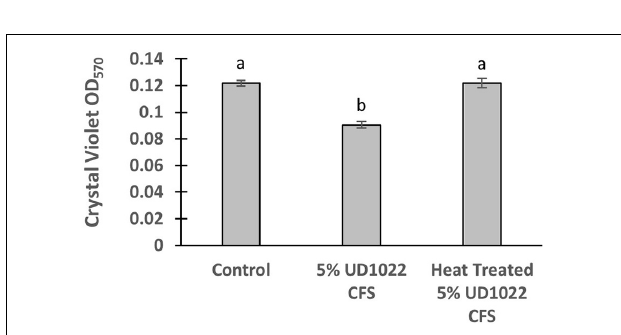
FIGURE 2 | Rm8530 biofilm formation assay. Treatment with 5% UD1022 CFS significantly reduced the formation of biofilm by Rm8530 ( p -value of < 0.0001). Treatment with ‘heat treated’ UD1022 CFS showed no significant difference compared to the control ( p -value of